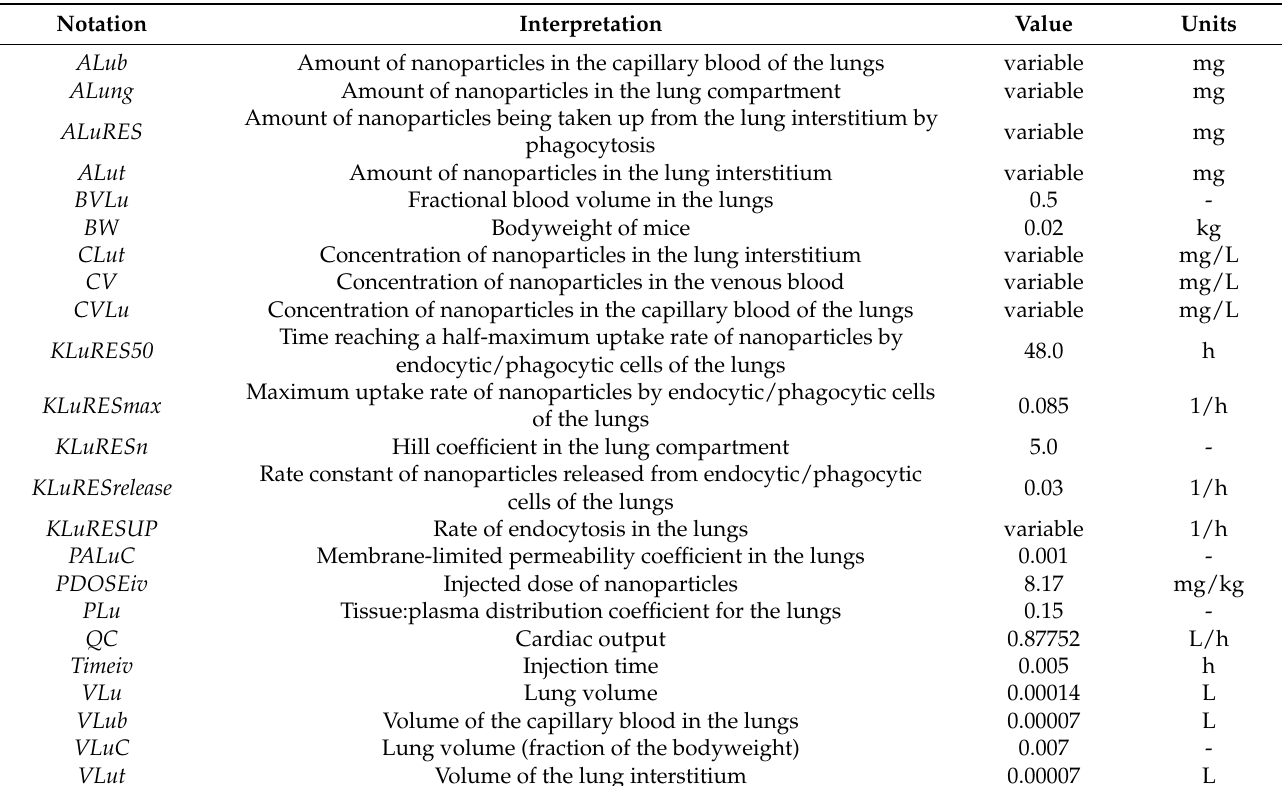
Table 1. The list of variables and parameters used in the model of nanoparticle delivery by Cheng et